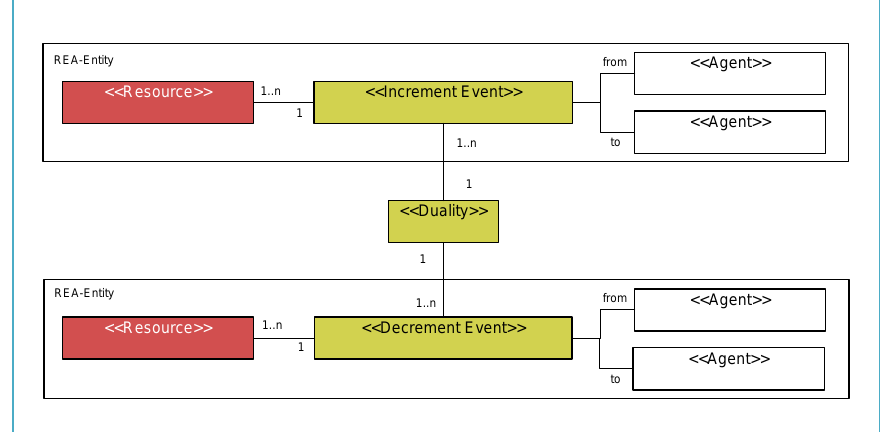
Figure 4. Reified Duality relationship – UML